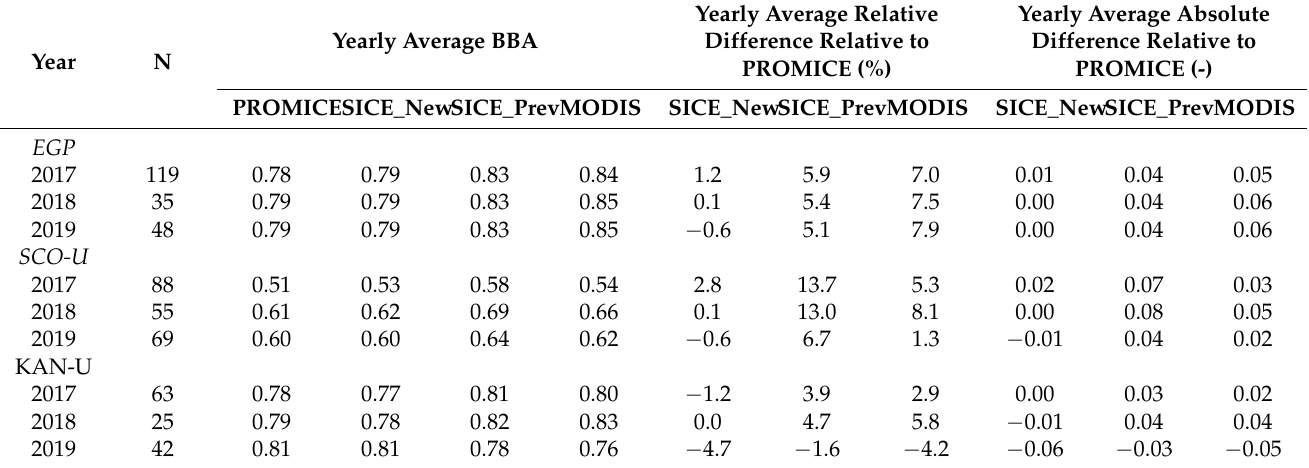
Table 6. Broadband albedo (BBA) statistics at three PROMICE AWS (EGP, SCO-U, KAN-U) and evaluation of the BBA retrievals from the current algorithm (SICE_new), previous version (SICE_prev) and MODIS for 2017, 2018, and 2019. N gives the number of collocated measurements by PROMICE, OLCI/S-3 and MODIS/Terra/Aqua (free of clouds).